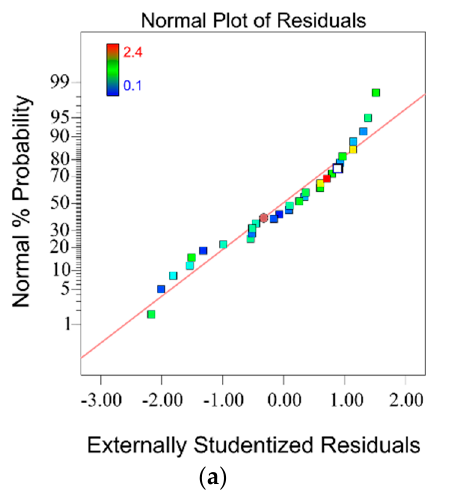
Figure 6. ( a ) Residual analysis of wear volume; ( b ) Wear volume comparison between the predicted and the actual.